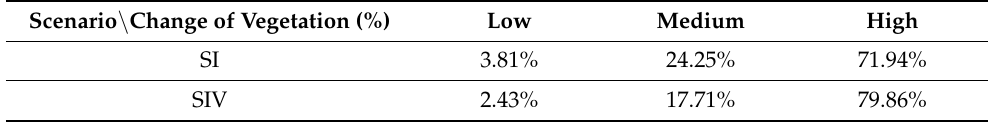
Table 6. The change of vegetation transfer at different levels in SI and